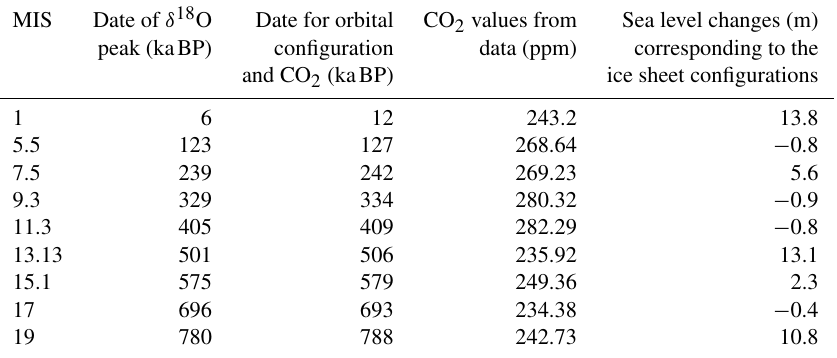
Table 1. Dates of orbital parameters and CO 2 used for the simulations (Lüthi et al., 2008), and sea level anomalies as compared to present-day conditions (m) corresponding to the prescribed ice sheets (Ganopolski and Calov,